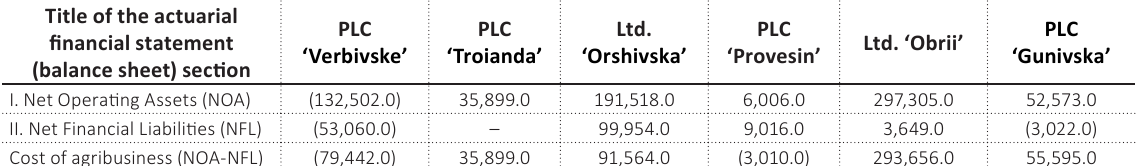
Table 2. Calculation of the agricultural enterprises’ value using the method of adjusted net assets (within the cost-effective